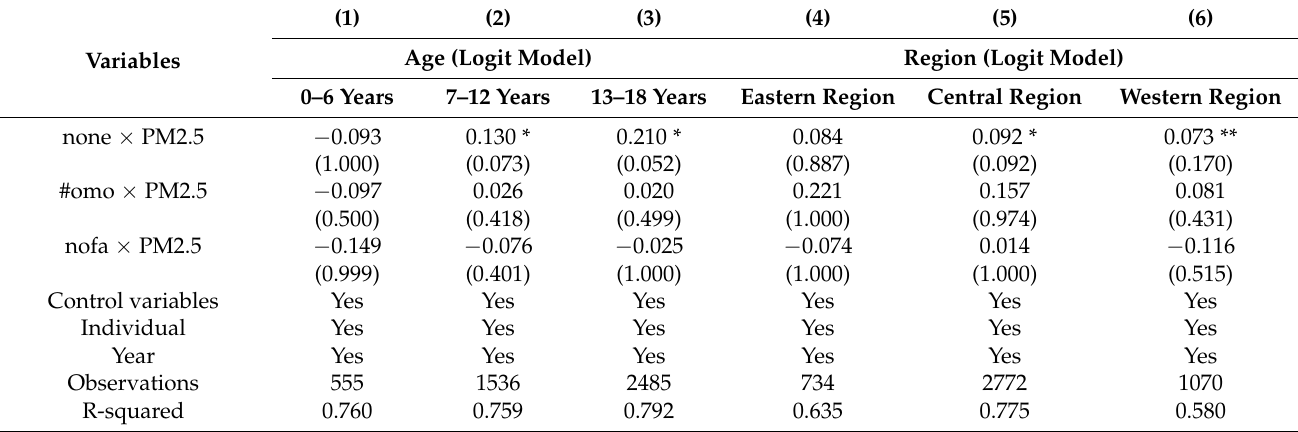
Table 4. Heterogeneity regression results for rural